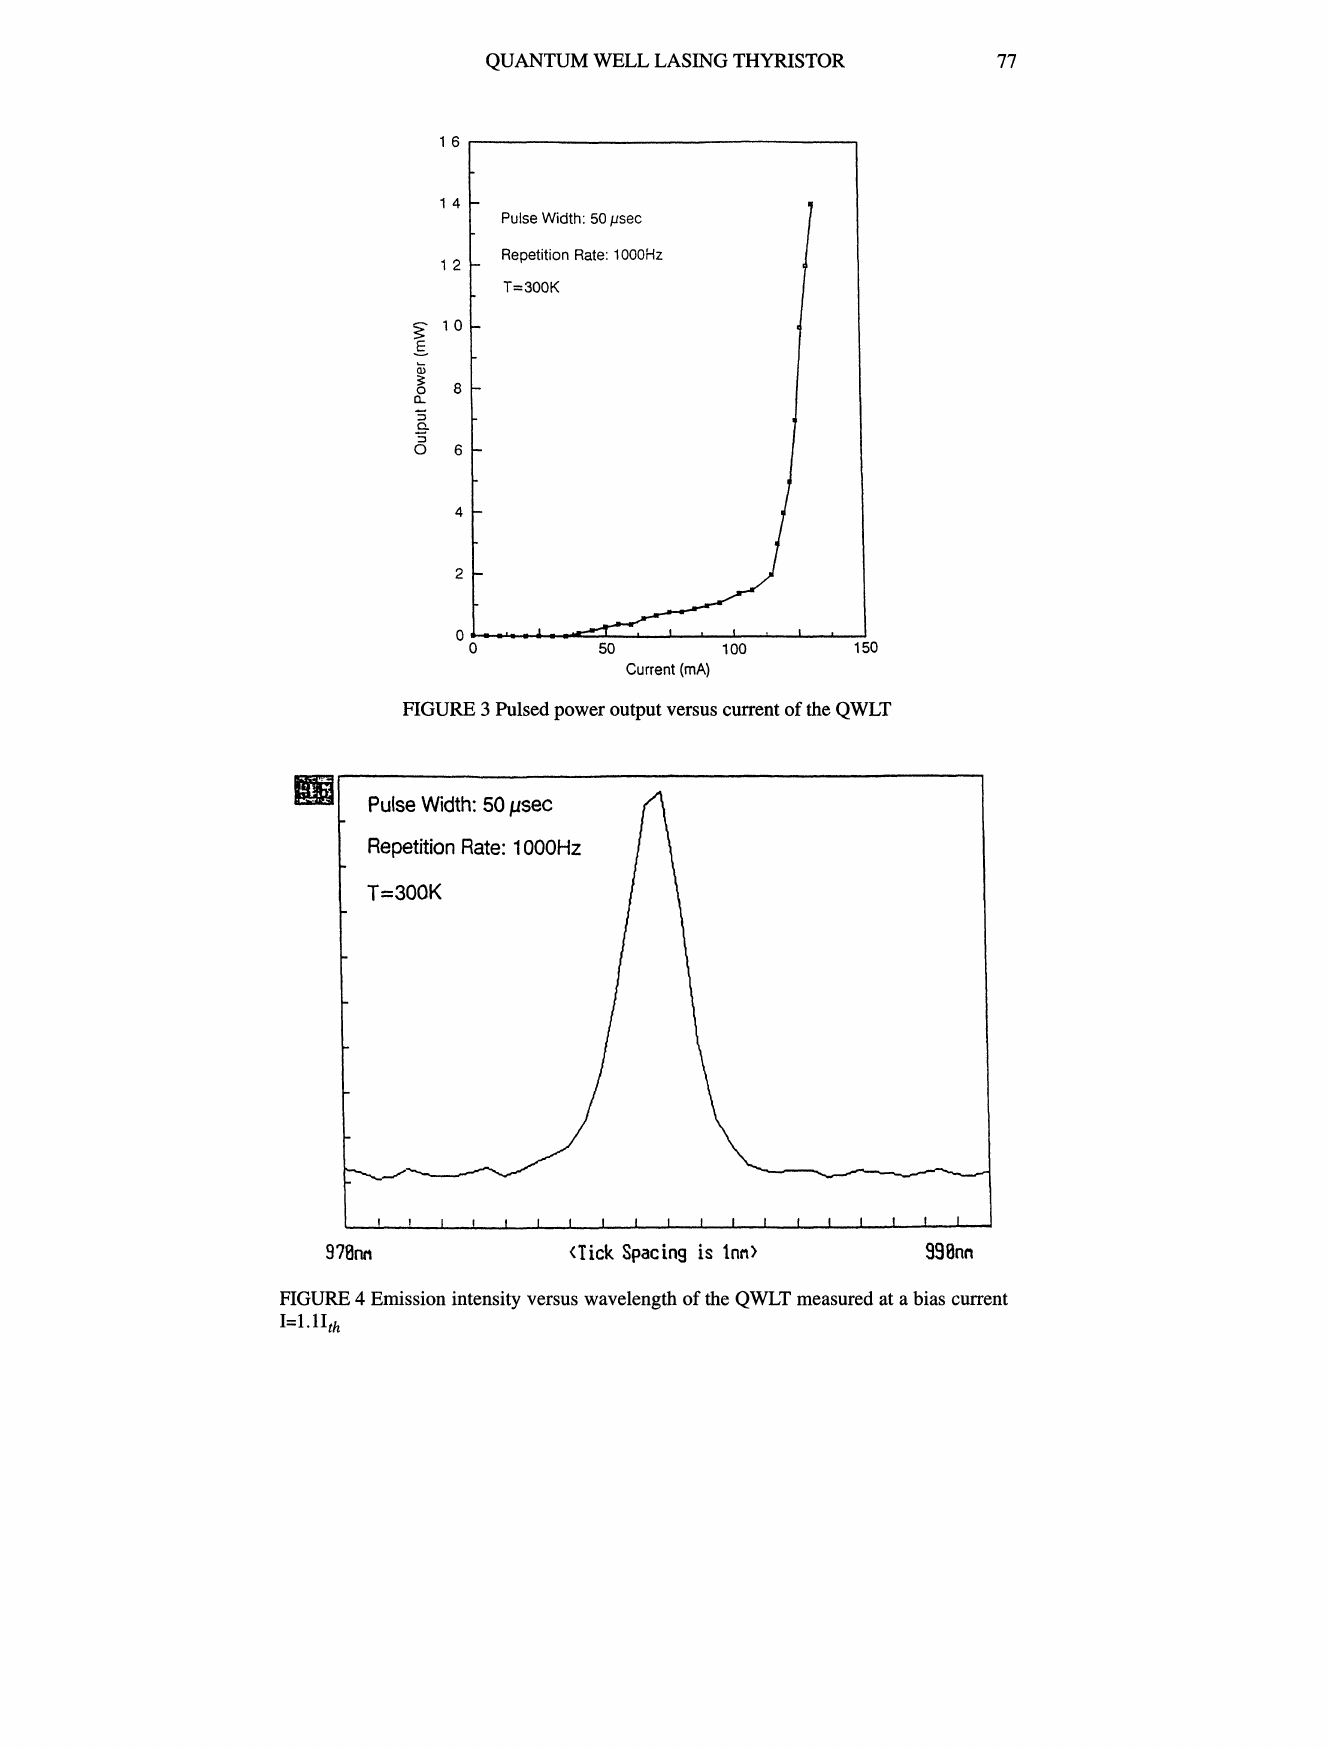
FIGURE 3 Pulsed power output versus current of the QWLT